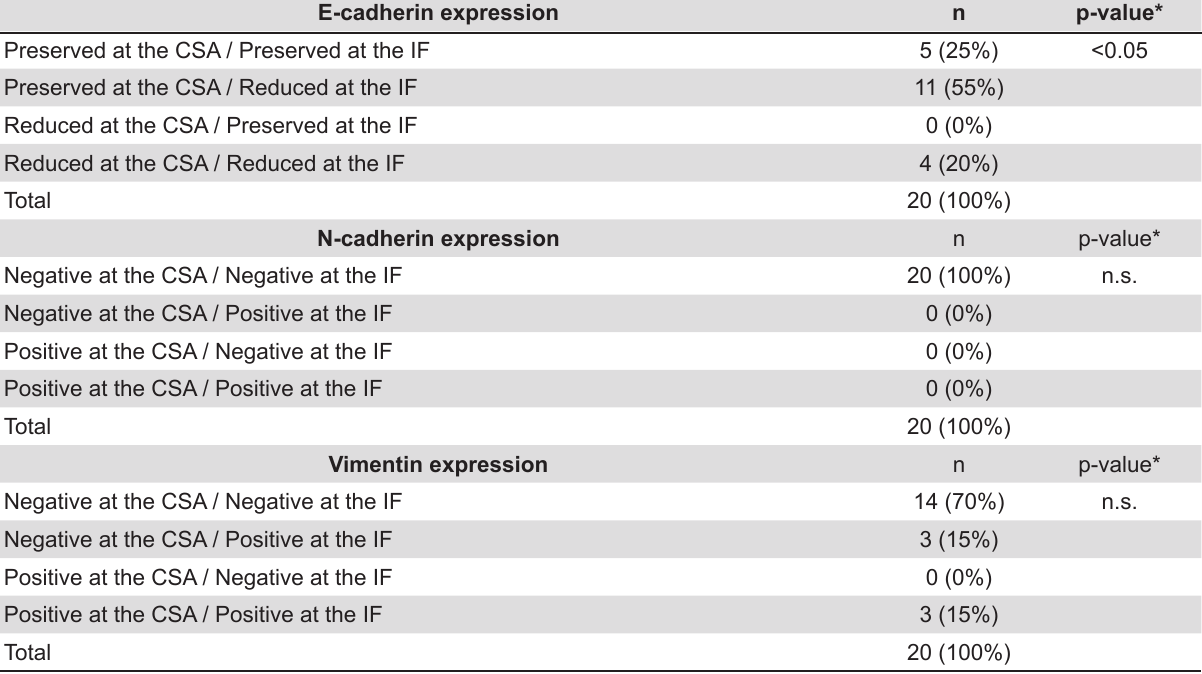
Table 1- E-cadherin, N-cadherin and vimentin expression at the invasive front (IF) and in the central/superficial areas (CSA) of oral squamous cell